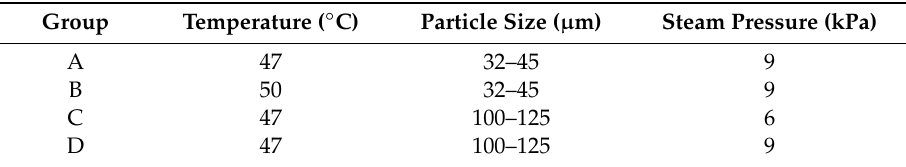
Table 2. Hydration reaction